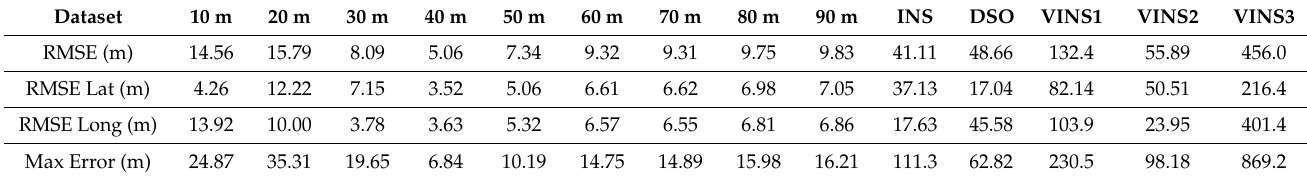
Table 1. Scenario 1 Localization Results (Trajectory Length: 992